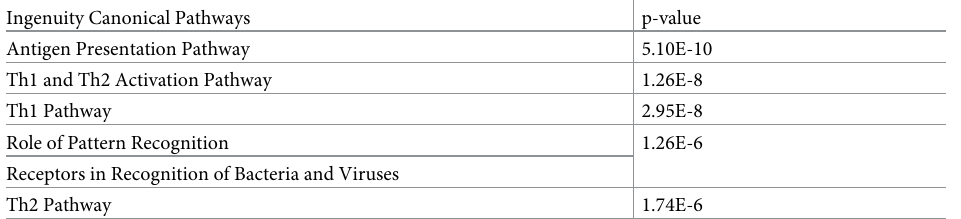
Table 2. Pathways analysis applied to the gene expression changes induced by IFN- γ in neutrophils of healthy subjects. Ingenuity Canonical